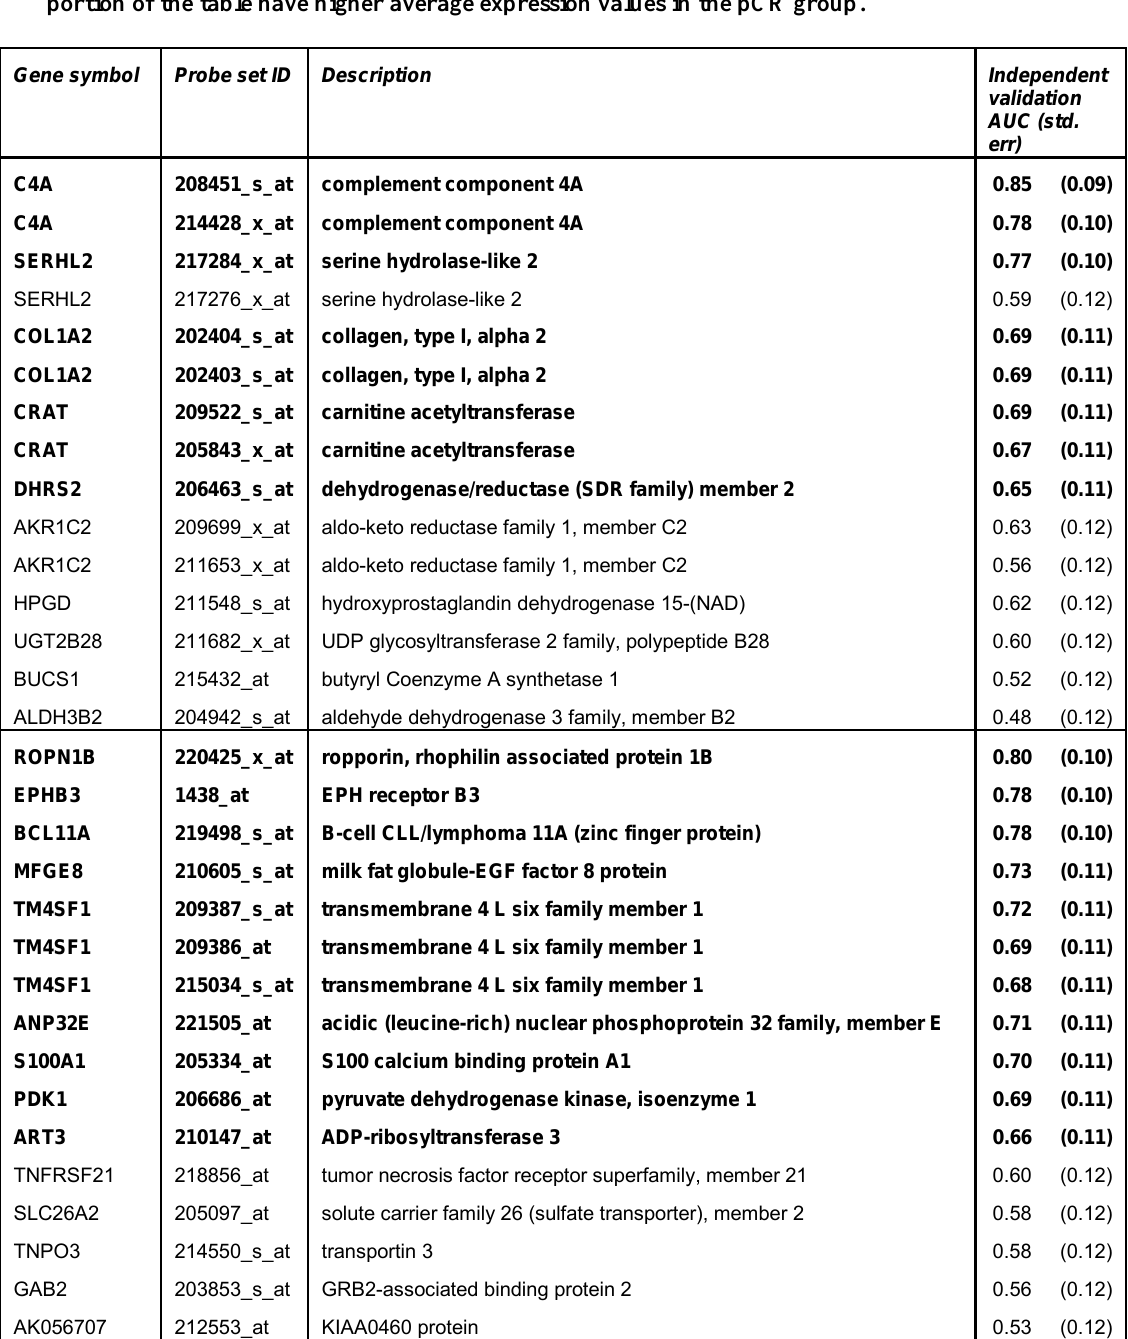
Table 1 Candidate markers identified in triple negative breast cancers for predicting chemotherapeutic response. The probe sets that can individually achieve reasonable validation performance (AUC > 0.65) are listed in bold face. The genes listed in the top portion of the table have higher average expression values in the non-pCR group; the genes listed in the bottom portion of the table have higher average expression values in the pCR